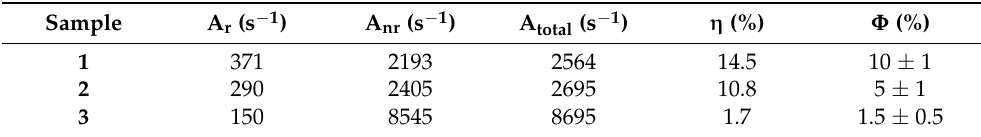
Table 3. Radiative ( A r ), nonradiative ( A nr ) and total ( A total ) decay rates, quantum efficiencies ( η ) of the 5 D 0 level of europium(III) and Eu 3+ luminescence quantum yields ( Φ ) upon excitation into 1 ππ * singlet electronic excited state of terephthalate ion terephthalates 1 – 3